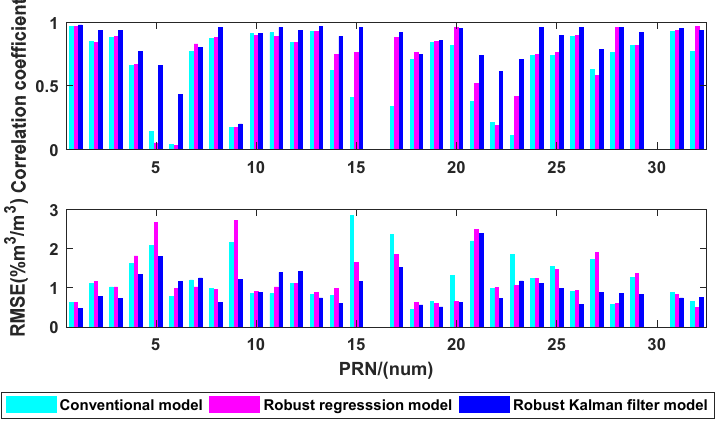
Figure 15. Correlation c oefficients and RMSE of dual-band with multivariate.